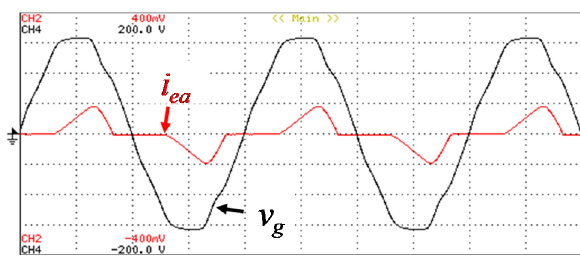
Figure 6. Experimental results without the operation of the MF-EVCS (in G2V mode): Ac-side voltage ( v g : 50 V / div); Electrical appliances current ( i ea : 10 A / div).